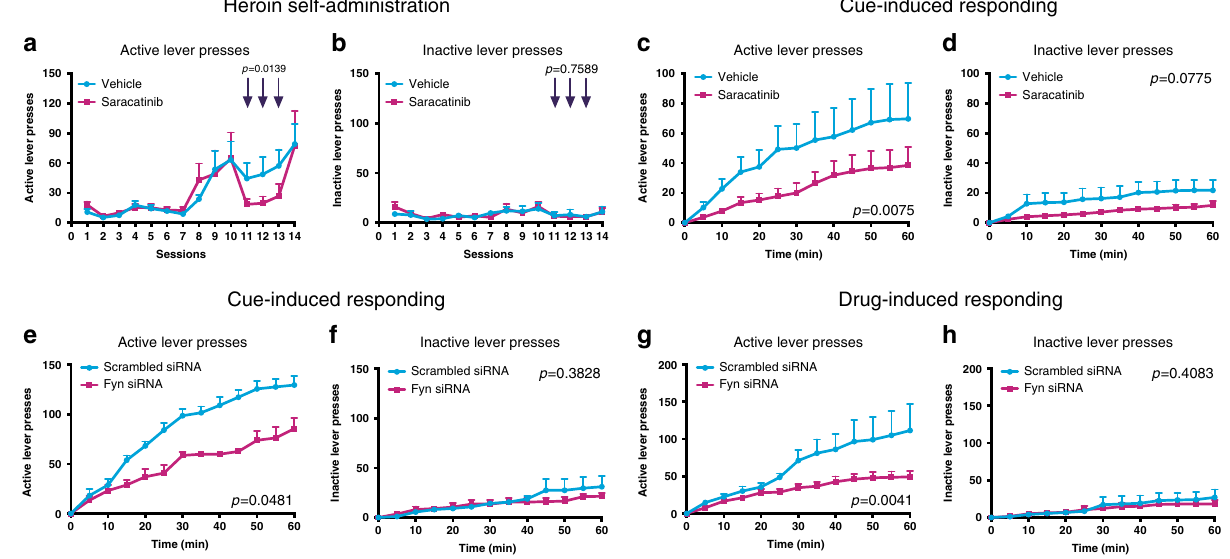
Fig. 6 Inhibition of Fyn attenuates heroin self-administration and cue-induced responding . a Active lever presses during 3 h long heroin self- administration session in vehicle and saracatinib treated Long-Evans rats. Arrows represent days of saracatinib administration. Two-way ANOVA revealed signi fi cant group effect ( n = 6/group, F 1,29 = 6.852, p = 0.0139) indicating decreased heroin self-administration behavior on days of saracatinib exposure. b Inactive lever presses were not affected in the same sessions ( n = 6/group, two-way ANOVA, F 1,29 = 0.096, p = 0.7589). c Active lever presses during a 1 h long, cue-induced, non-reinforced session in rats previously trained to self-administer heroin that were injected with vehicle or saracatinib ( n = 6/7 for vehicle/saracatinib, two-way ANOVA, F 1,132 = 7.376, p = 0.0075). Saracatinib signi fi cantly decreased responding for the heroin-paired stimulus. d Inactive lever presses were not affected in the same sessions ( n = 6/7 for vehicle/saracatinib, two-way ANOVA, F 1,132 = 3.165, p = 0.0775). e Active lever presses during a 1 h long, cue-induced, non-reinforced session in rats previously trained to self-administer heroin and subjected to siRNA-mediated knock-down (KD) of Fyn in the dorsal striatum 3 days prior to the session ( n = 5/group, two-way ANOVA, F 1,96 = 4.007, p = 0.0481). KD of Fyn signi fi cantly decreased responding to the heroin-paired cue. f Inactive lever presses were not affected in the same sessions ( n = 5/group, two-way ANOVA, F 1,96 = 0.7685, p = 0.3828). g Active lever presses during a 1 h long, drug-induced, non-reinforced session in rats previously trained to self-administer heroin and subjected to siRNA-mediated knock-down of Fyn in the dorsal striatum 3 days prior to the session ( n = 6/group, two-way ANOVA, F 1,120 = 8.545, p = 0.0041). KD of Fyn signi fi cantly decreased active lever pressing. h Inactive lever presses were not affected in the same sessions (n = 6/group, two-way ANOVA, F 1,120 = 0.6884, p = 0.4083). Data are represented as mean ± SEM. Source data are provided as a Source Data fi